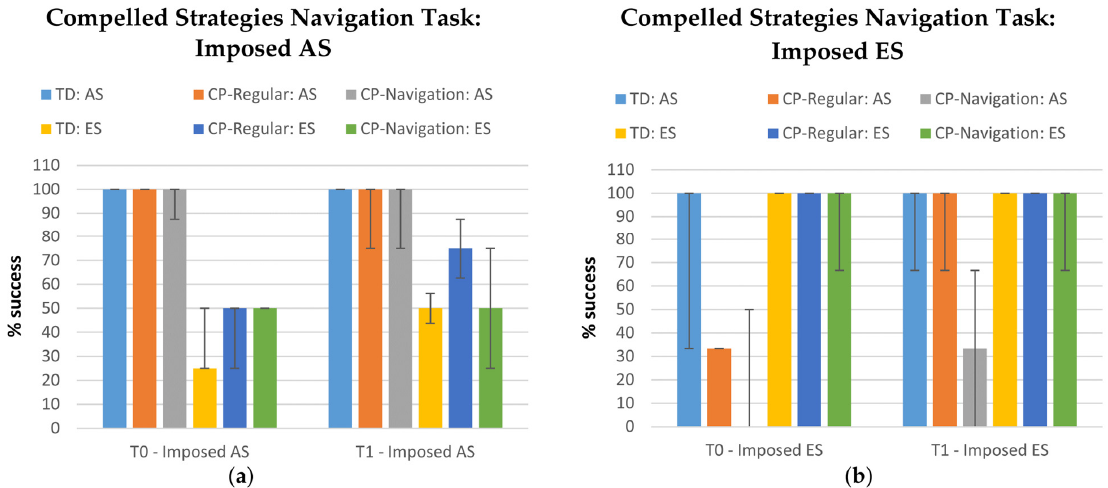
Figure 6. Success (express as percentage) for the trials with imposed allocentric ( a ) and egocentric ( b ) strategies, both at T0 and T1, in TD, CP ‐ Regular, and CP ‐ Navigation participants grouped according to their orienting strategy adopted during the Free Navigation Task (AS and ES sub ‐ groups).